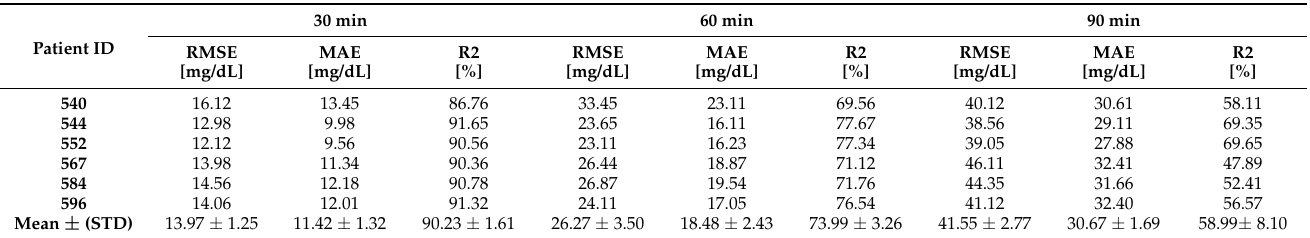
Table 5. Patient-wise analysis results with CNN-LSTM model, given scenario 7. MAE, RMSE and R2 of BG prediction for personalized training for each patient separately, for 30 to 90 min PH.